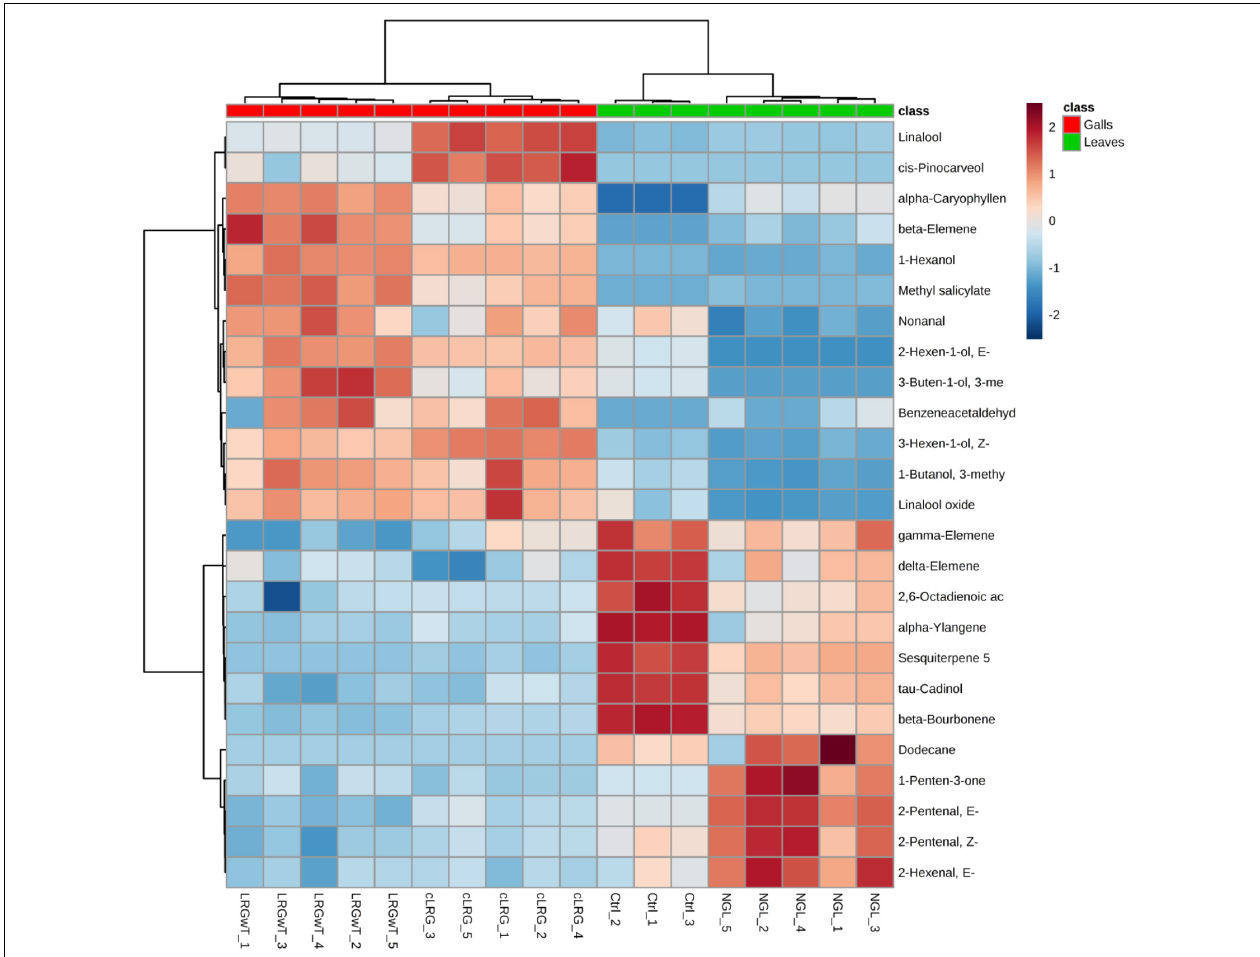
FIGURE 5 | Profile of the distribution of VOCs in non-galled leaves and galls. Plot shows the heat map distribution of the 25 most discriminating VOCs identified by SPME-GC-MS analysis. Color key indicates metabolite expression value, blue: Lowest, red: highest.